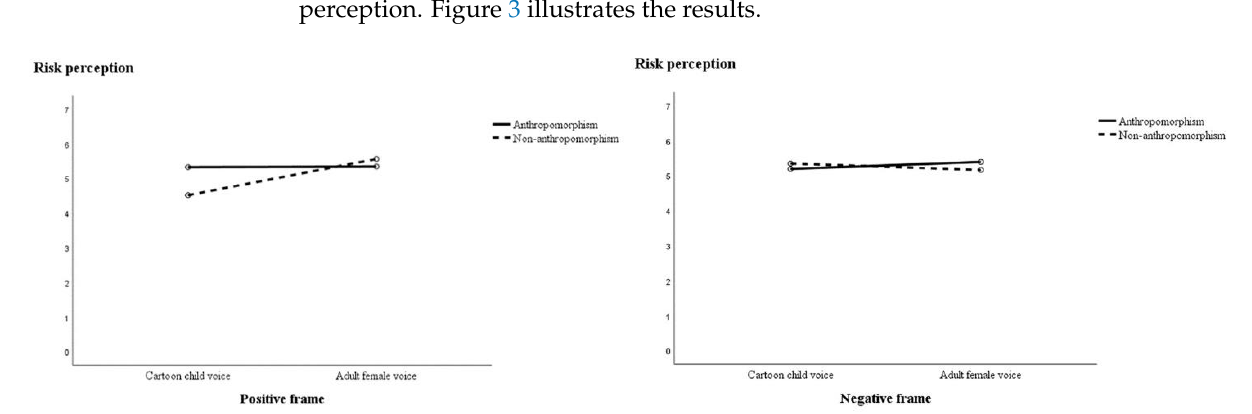
Figure 3. The effects of anthropomorphism on risk perception by voice type and message frame.